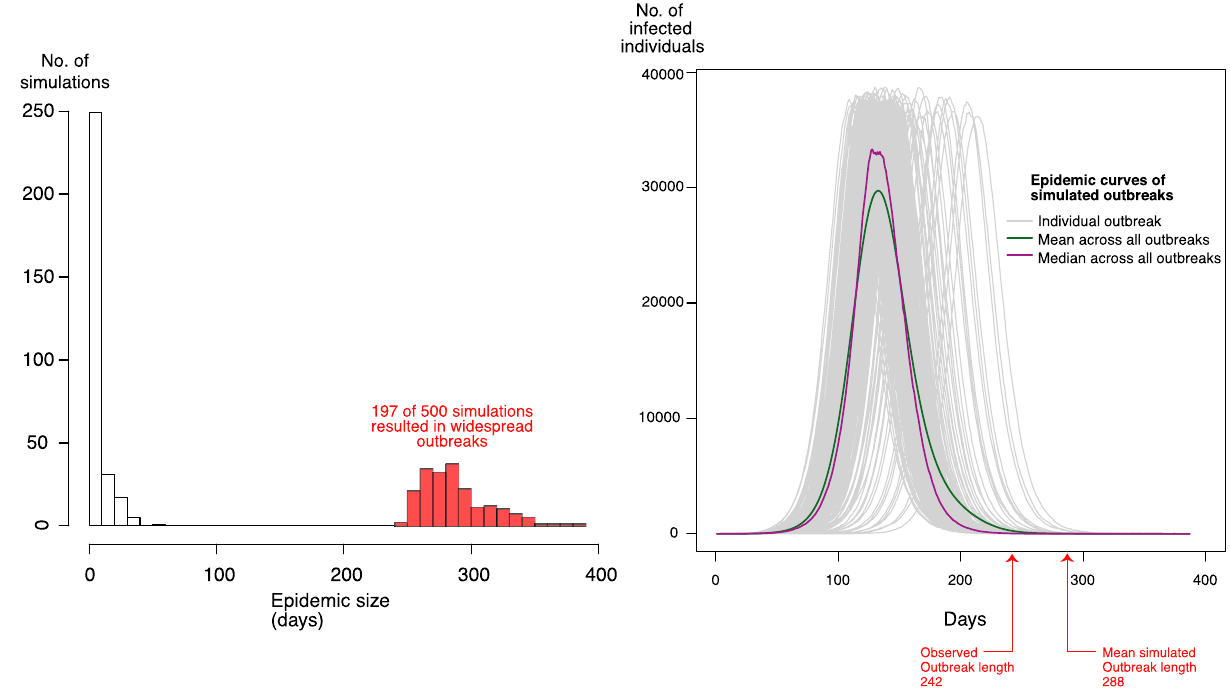
Figure 4. Left: Histogram of simulation lengths (epidemic sizes) of 500 simulations, 197 of which resulted in widespread geospatial outbreaks (infecting greater than 1,000 nodes corresponding to urban areas in Rwanda). Right: Infectious epidemic curves (progression of influenza infections over time) of the 197 simulations that resulted in widespread geospatial outbreaks. The red arrows point out the reported length of the observed 2009 pH1N1 outbreak in Rwanda (242 days) and the mean simulated outbreak length (287.8 days).